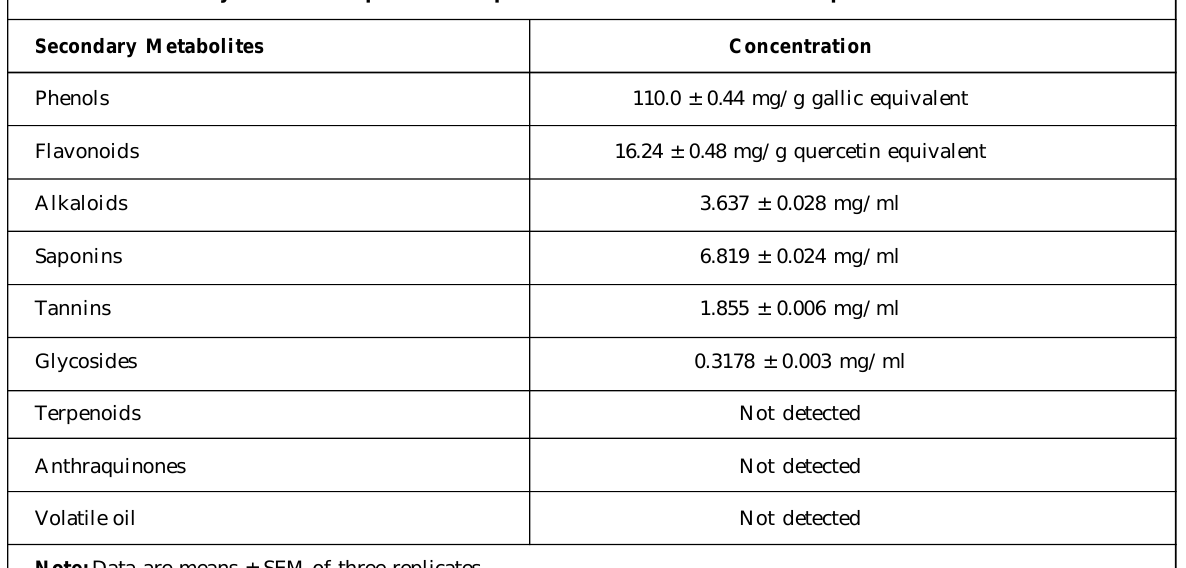
Table 1: Secondary metabolites present in aqueous extract of A. nilotica seedpod Secondary Metabolites